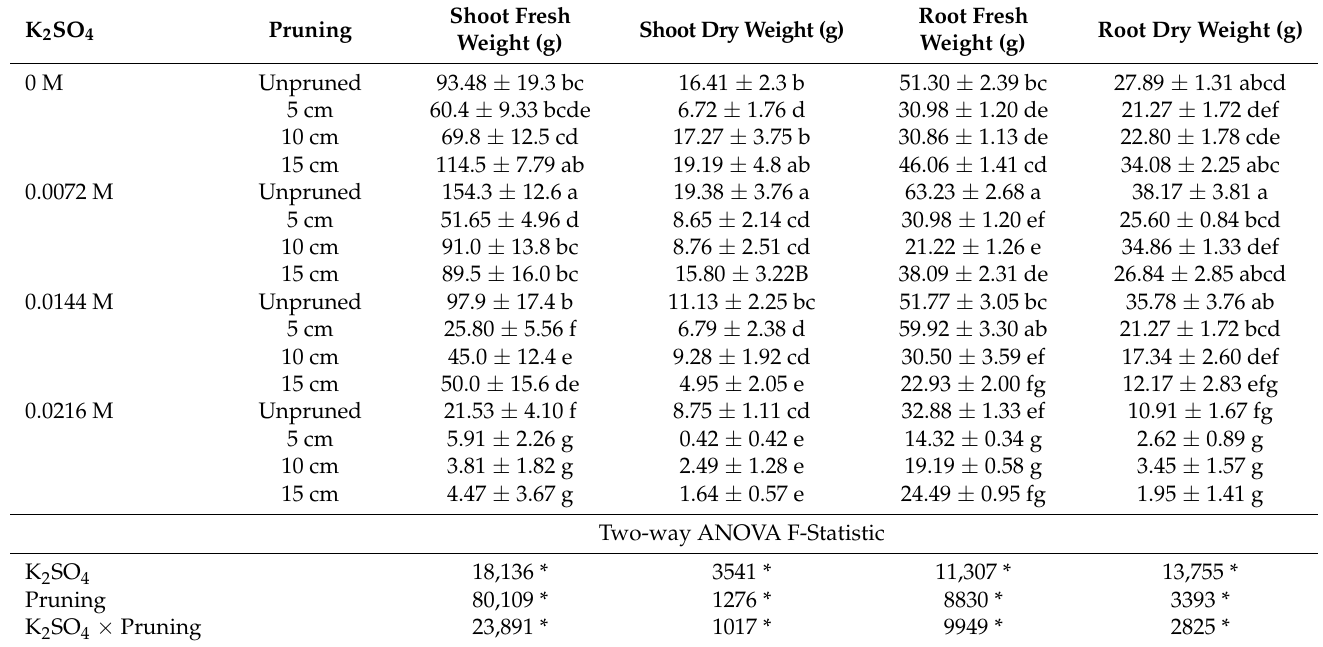
Table 2. The effect of potassium and pruning levels on the fresh and dry weight of shoots and roots of hydroponically grown T. divaricata